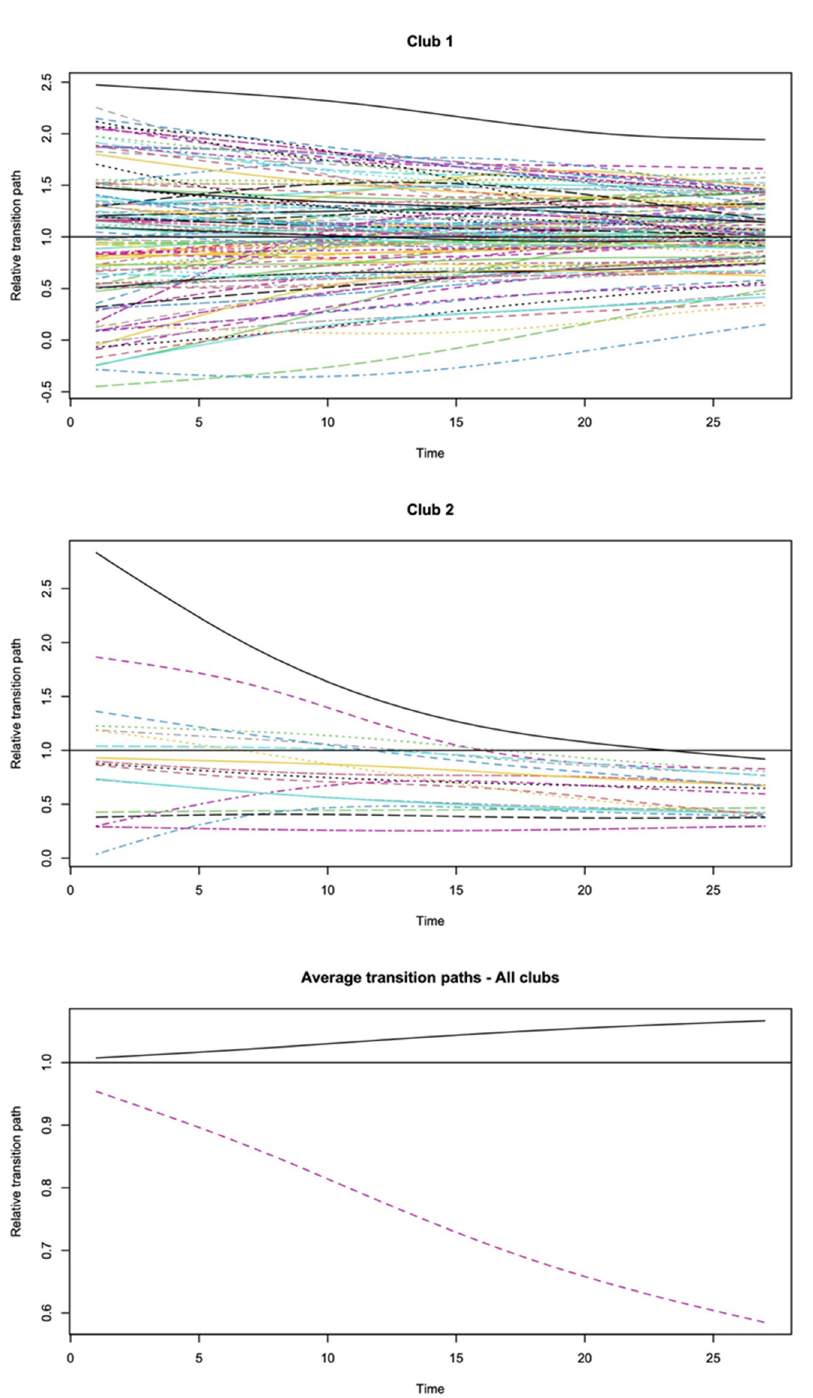
Figure 3. Convergence in relative transition path (country and average). Source: authors’ research.